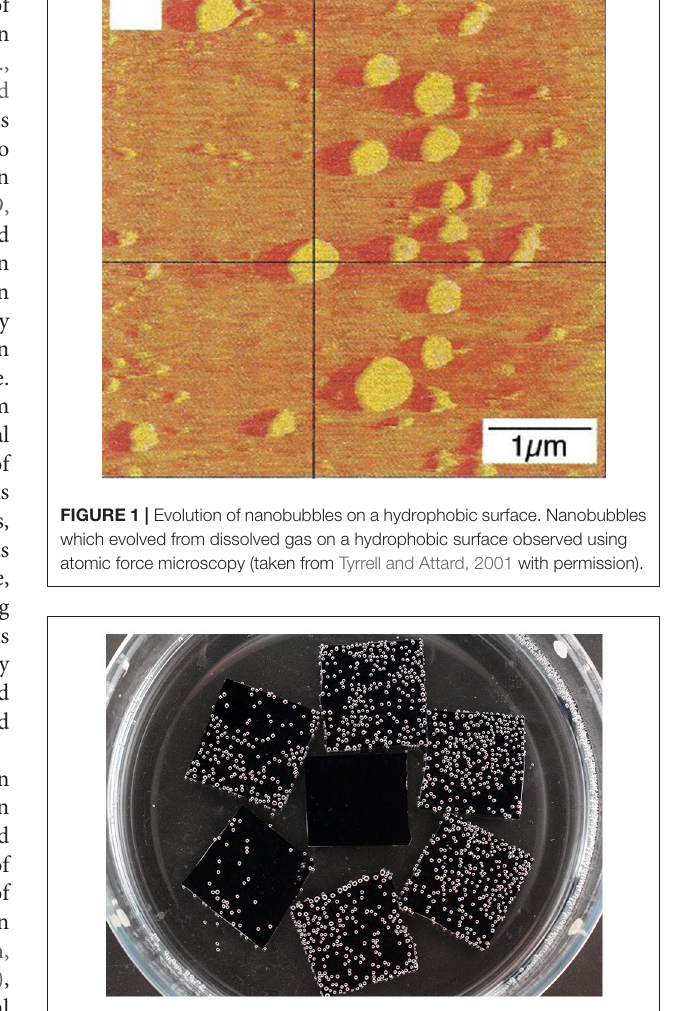
Frontiers in Physiology |